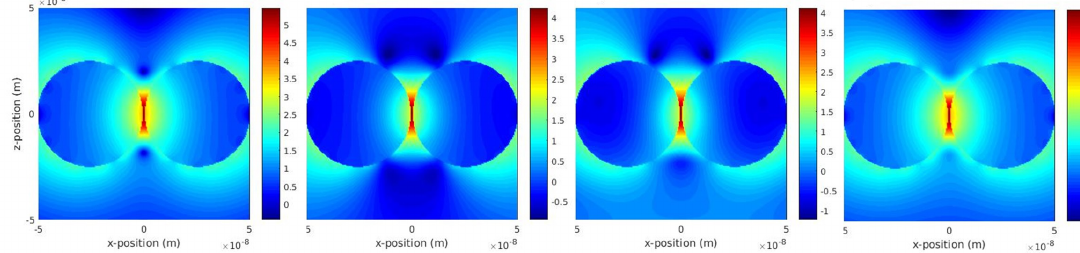
Figure 8. Electric field intensity enhancement (logarithmic scale) for Ag, Au, Al and Cu dimers (left to right) with radius a = 25 nm embedded in water and interparticle separation of 1 nm. Excitation polarisation is parallel to the dimer axis and the near field map corresponds to the plane defined by the polarisation and propagation directions. Calculations are done at the resonance photon